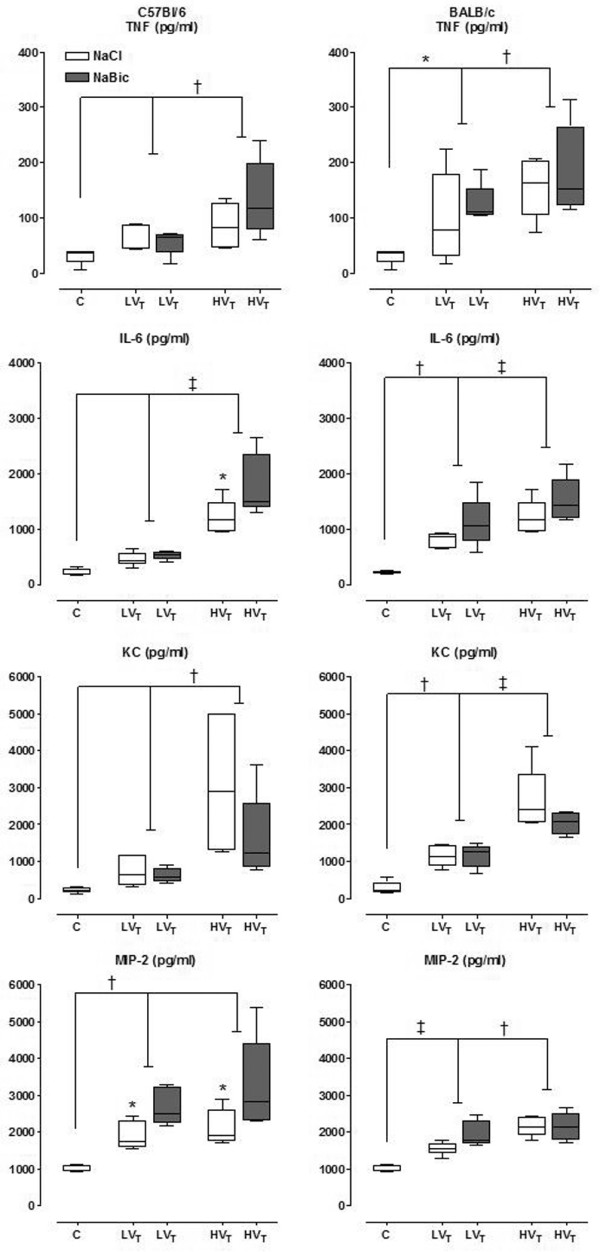
Pulmonary levels of tumour necrosis factor (TNF)-α, interleukin (IL)-6, keratincyte-derived cytokine (KC) and macrophage inflammatory protein (MIP)-2 in lung tissue homogenate. Pulmonary levels of TNF-α, IL-6, KC and MIP-2 and in lung tissue homogenate in control mice, and in mice ventilated with low tidal volumes (LVT) and high VT (HVT) for five hours. Two fluid strategies (normal saline (white boxes) and sodium bicarbonate (grey boxes)) were compared. Data represent median and interquartile range of six mice. *p < 0.05 (LVT vs. control or sodium bicarbonate vs. saline, IL-6 and MIP-2 in C57Bl/6 mice); †p < 0.01 (HVT vs. LVT or LVT vs. control); ‡p < 0.001 (HVT vs. LVT or LVT vs. control).